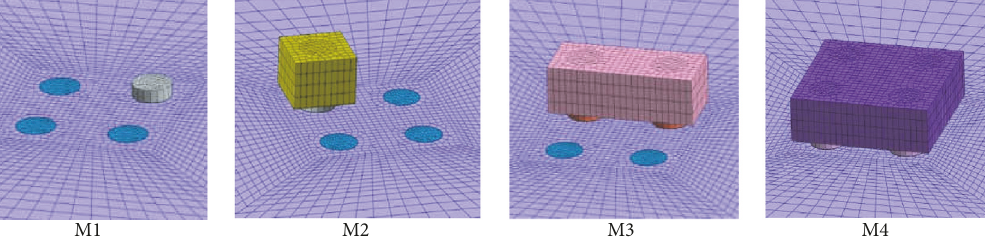
Figure 12: FE models of the cap-pile-soil system.